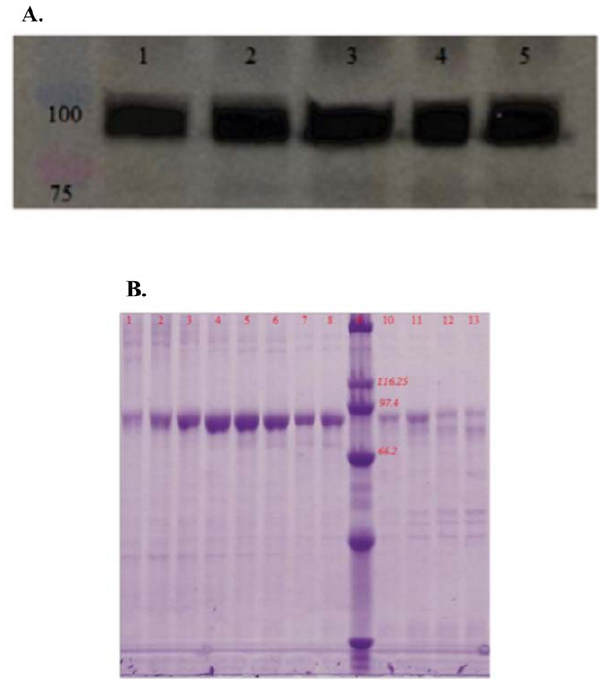
Figure 1. Purification of human AOC3 expressed by s2 Drosophila cells. A. Immunoblot of fractions obtained after ion exchange column chromatography, showing human AOC3 at the expected mass. Protein ladder to the left of Lane 1 (top band, blue 2 100 kDa; bottom band, red 2 75 kDa). B. 10% acrylamide, denaturing SDS-PAGE gel electrophoresis of fractions using a Laemmli buffering system after gel filtration column chromatography. Fractions repre- sented in lanes 4 to 8 and 10 were isolated and concentrated for further characterization. Protein ladder shown in Lane 9 (second band from top 2 116 kDa, third band 2 97 kDa, fourth band 2 66 kDa). Approximately 0.25–2 ug of protein was loaded into each lane.